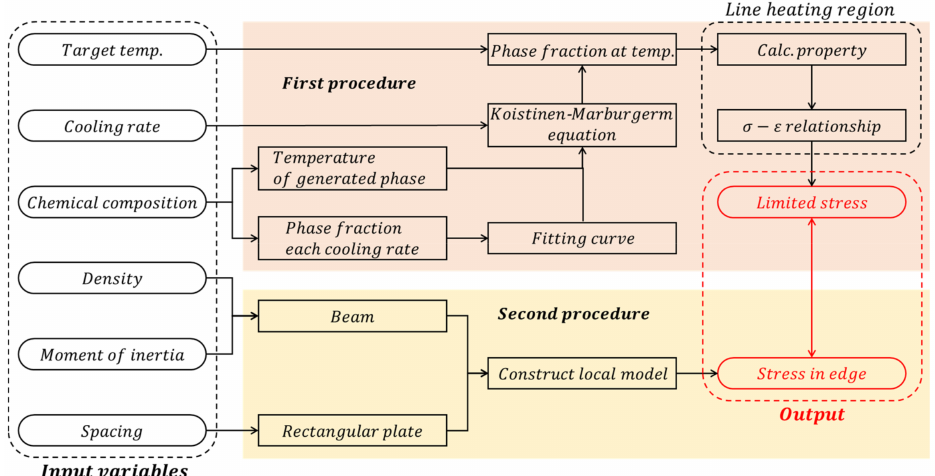
Figure 1. Procedures for determining the